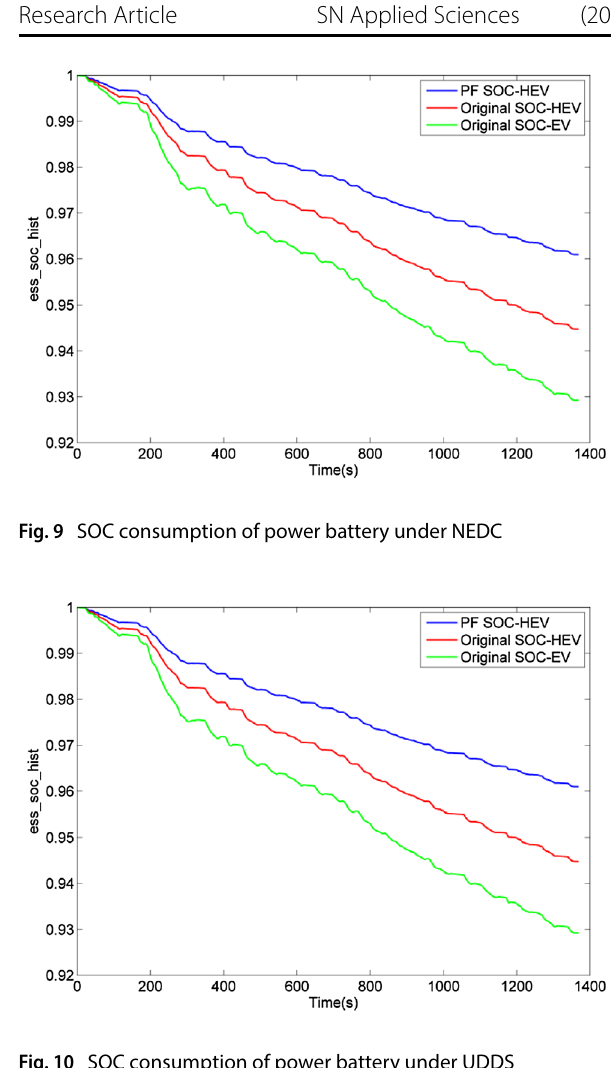
Fig. 10 SOC consumption of power battery under UDDS